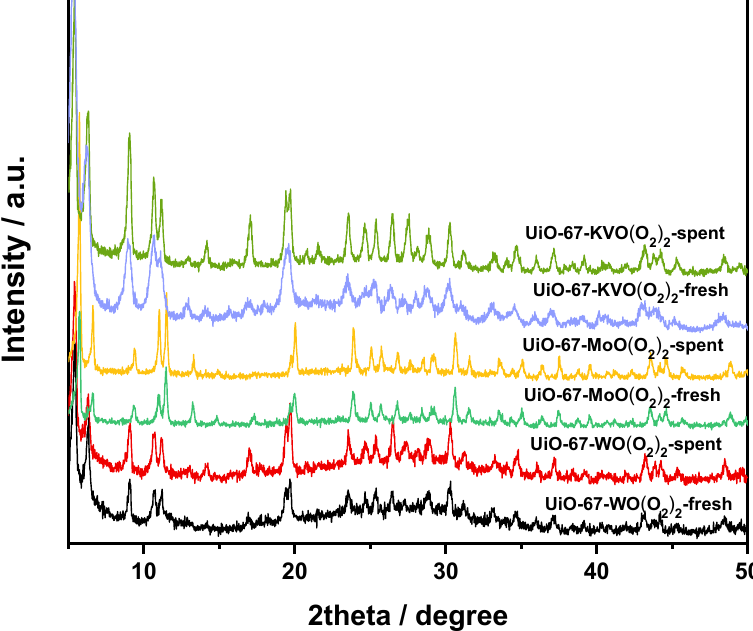
Figure 5. XRD patterns of UiO-67-MoO(O 2 ) 2 , UiO-67-WO(O 2 ) 2 , and UiO-67-KVO(O 2 ) 2 before and after reactions.